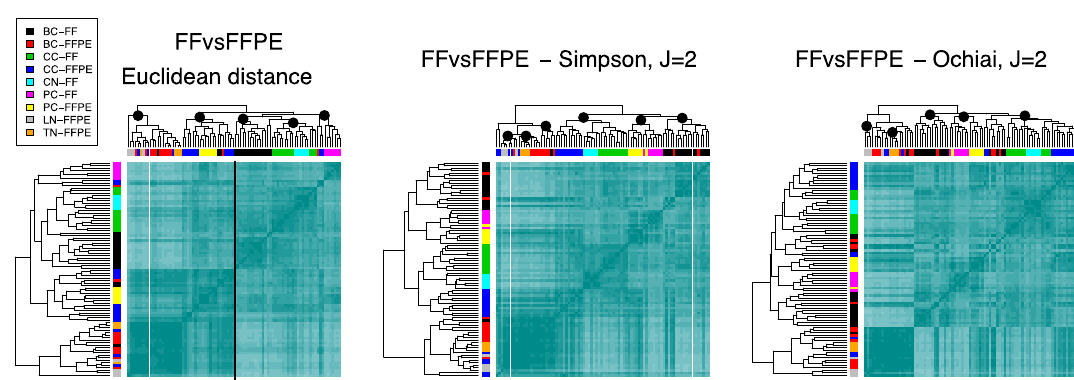
Figure 9. Clustering the FFvsFFPE data set. Dendrograms and heatmaps for the FFvsFFPE data set, using the Euclidean distance (left), the Simpson (middle) and the Ochiai (right) indices, with J = 2 . Main branches are highlighted with black